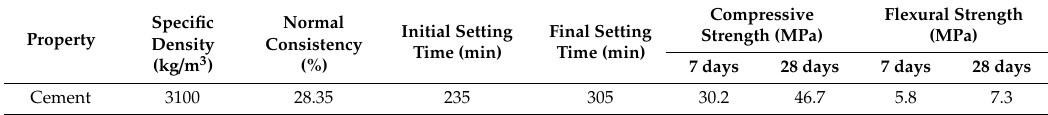
Table 1. Physical properties of